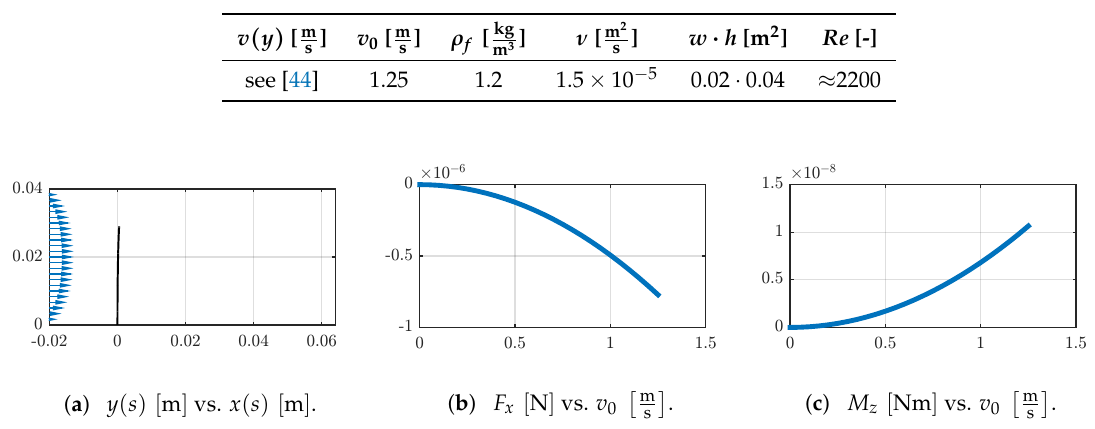
Table 4. Parameters for the simulation of an air flow inside a rectangular duct.